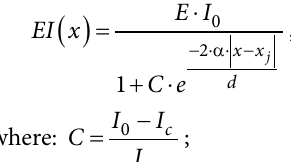
Figure 12. Transient heat transfer of a beam Table 6. Energy equilibrium parameters and symbols Symbol Parameter Unit p density kg/m 3 specific heat capacity